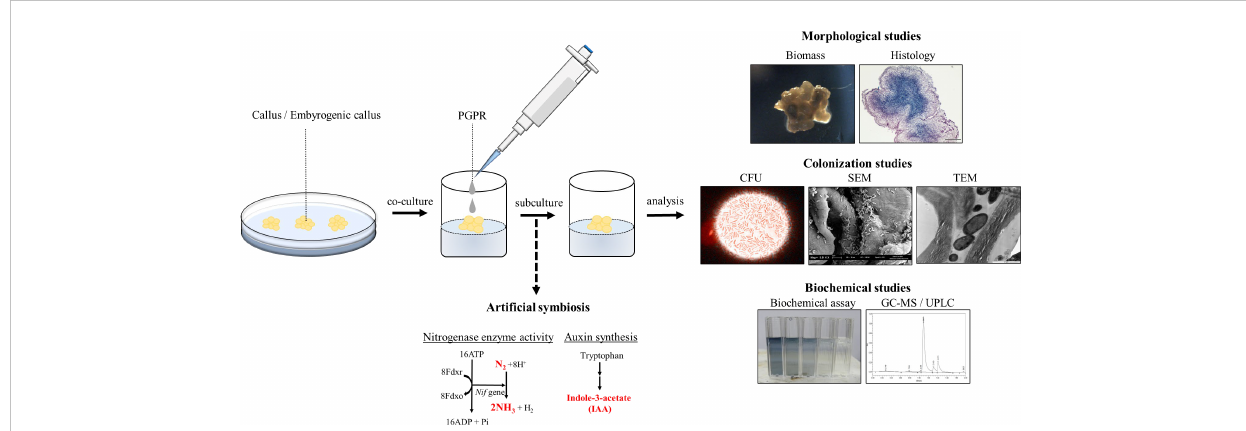
FIGURE 2 Schematic diagram of the biotization process. Arti fi cial symbiosis can be created via co-culture of selected PGPR with in vitro plant materials. Morphological studies, colonization studies, and biochemical studies are necessary assays to identify the in vitro plant material-microbe interactions. PGPR, plant growth promoting rhizobacteria; CFU, colony form unit; SEM, scanning electron microscope; TEM, transmission electron microscope; GC-MS, Gas chromatography-mass spectrometry; UPLC, ultra-performance liquid